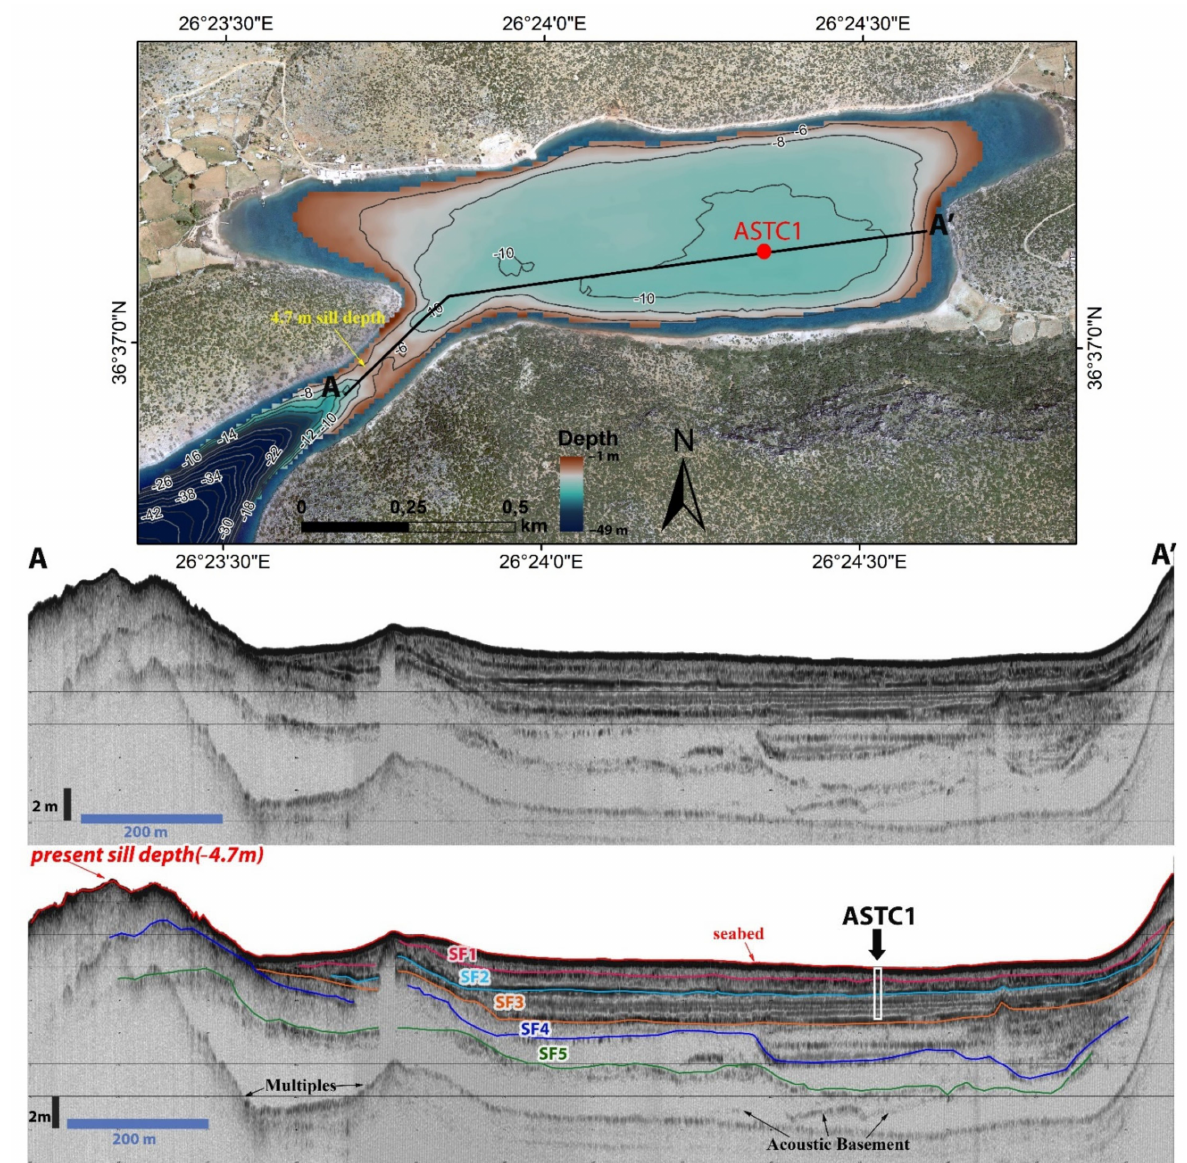
Figure 2. Bathymetric map of the gulf, showing the location of the seismic line AA’ and the sediment core drilling location (top right). High-resolution seismic profile with a 5.5 × vertical exaggeration of the sedimentary basin of Vathy (the uninterpreted above and the interpreted below). The interpreted profile shows the boundaries of the recognized seismic facies, the coring site, and the retrieved sedimentary units (white